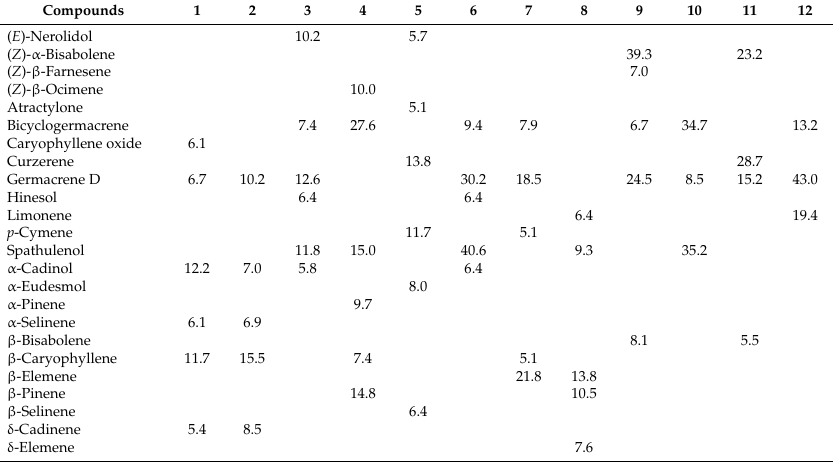
Table 16. Chemical compositions (%) of Piper dilatatum Rich. aerial parts essential oils from Brazil [32].